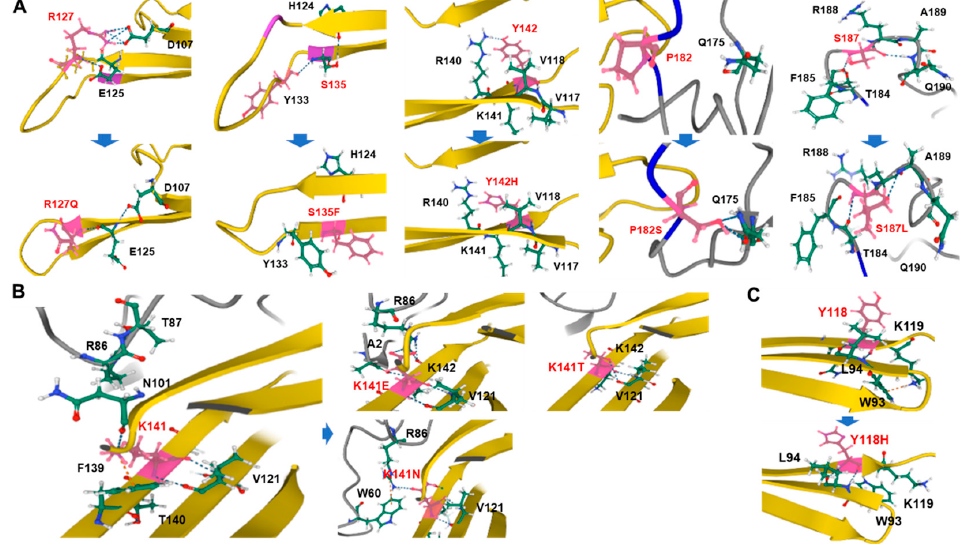
Figure 4. Predicted 3D conformational changes of neighboring structures of causative (pathogenic or likely pathogenic) mutation sites in three small heat shock proteins. Wild type protein structures and their mutant structures are provided up (or left) and down (or right) in each pair. The amino acid sites with mutation are indicated in pink. Hydrogen bonds are indicated by blue dotted lines, and carbon, hydrogen, nitrogen, and oxygen are indicated in green, gray, blue, and red, respectively. Noncovalent molecular interactions (cation– π interaction) are indicated by orange dotted lines. The crystal structures of α -crystallin domains are colored in yellow; N- and C-terminal domains are de- picted in gray. Wild and mutant proteins are illustrated by ribbon diagrams. ( A ) HSPB1, ( B ) HSPB8, and ( C ) HSPB3.